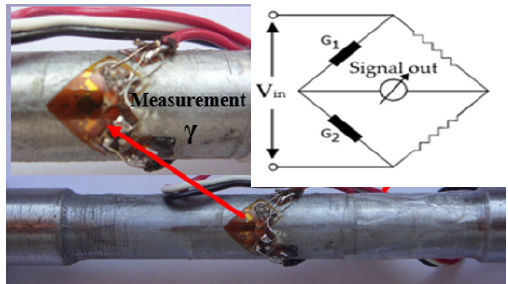
Figure 8. Measuring shear strain using tensometric transducers (two strain gauges).